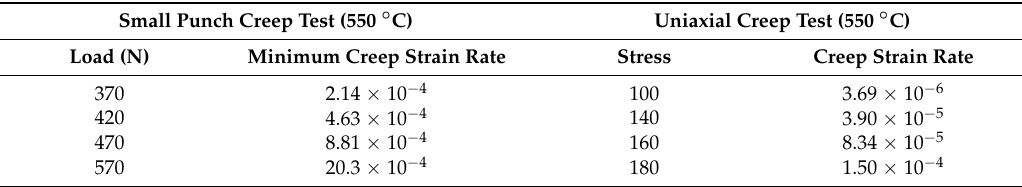
Table 3. The minimum creep strain rates under each load or stress levels of 1.25Cr0.5MoSi.